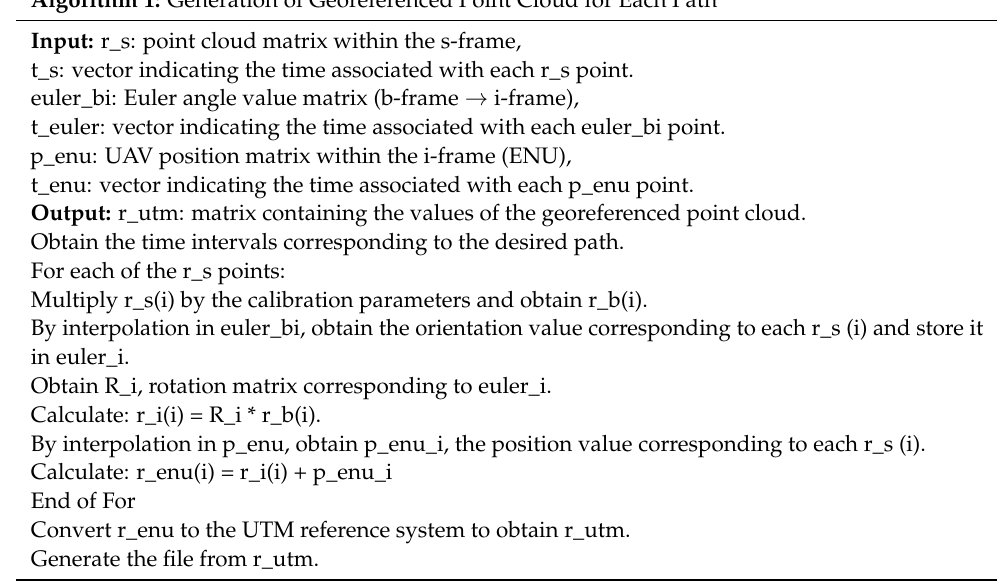
Figure 12. Point cloud PC calibrated using static variables in the UAV reference system (x’, y’, z’). Algorithm 1 denotes the development of the georeferenced point cloud for each path. Algorithm 1: Generation of Georeferenced Point Cloud for Each Path